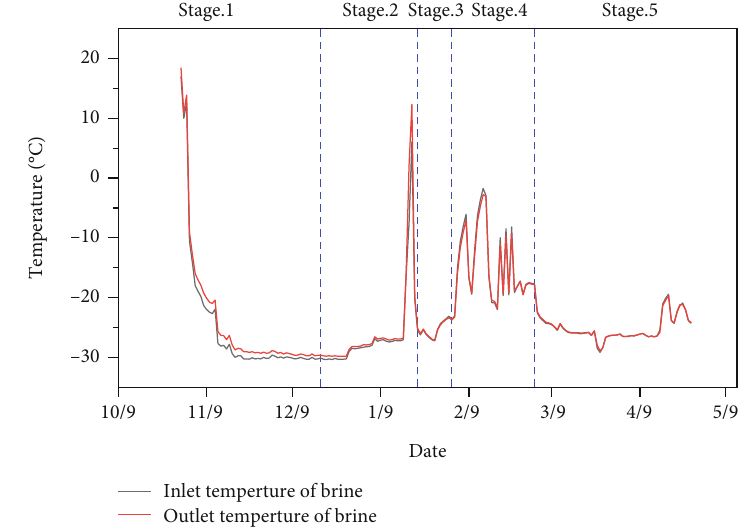
Figure 5: The temperature of brine in main pipe.